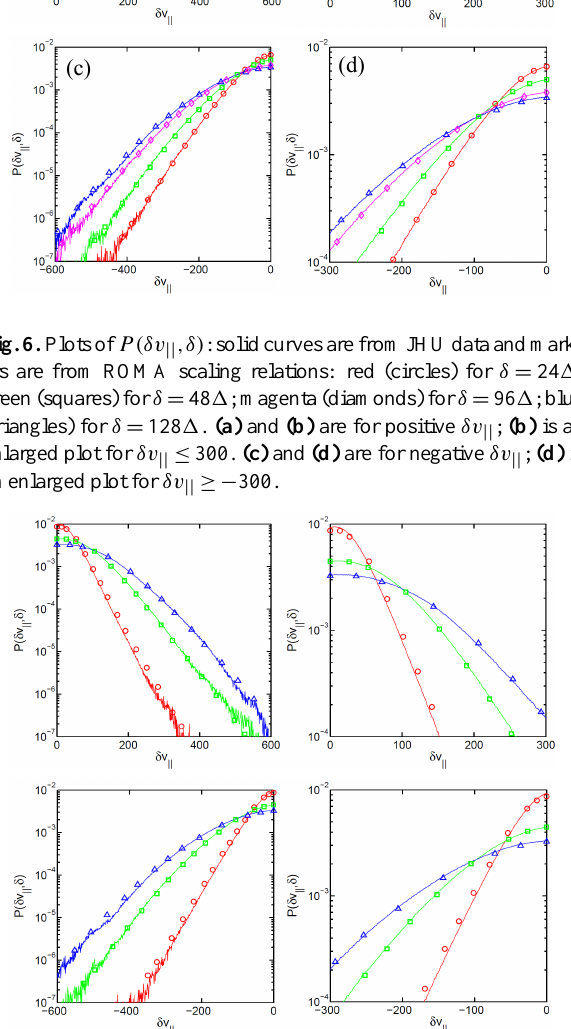
Fig. 7. Plots of P(δv || ,δ) : solid curves are from JHU data and markers are from ROMA scaling relations: red (circles) for δ = 12 1 ; green (squares) for δ = 64 1 ; blue (triangles) for δ = 140 1 . (a) and (b) are for positive δv || ; (b) is an enlarged plot for δv || ≤ 300. (c) and (d) are for negative δv || ; (d) is an enlarged plot for δv || ≥ − 300. Note the agreement between the calculated values from ROMA and data at δ = 12 1 and 140 1 is not as good as the one in Fig. 6 for δ from 24 1 to 128 1 . This probably is because δ = 12 1 is close to the dissipation range and δ = 140 1 close to the injection